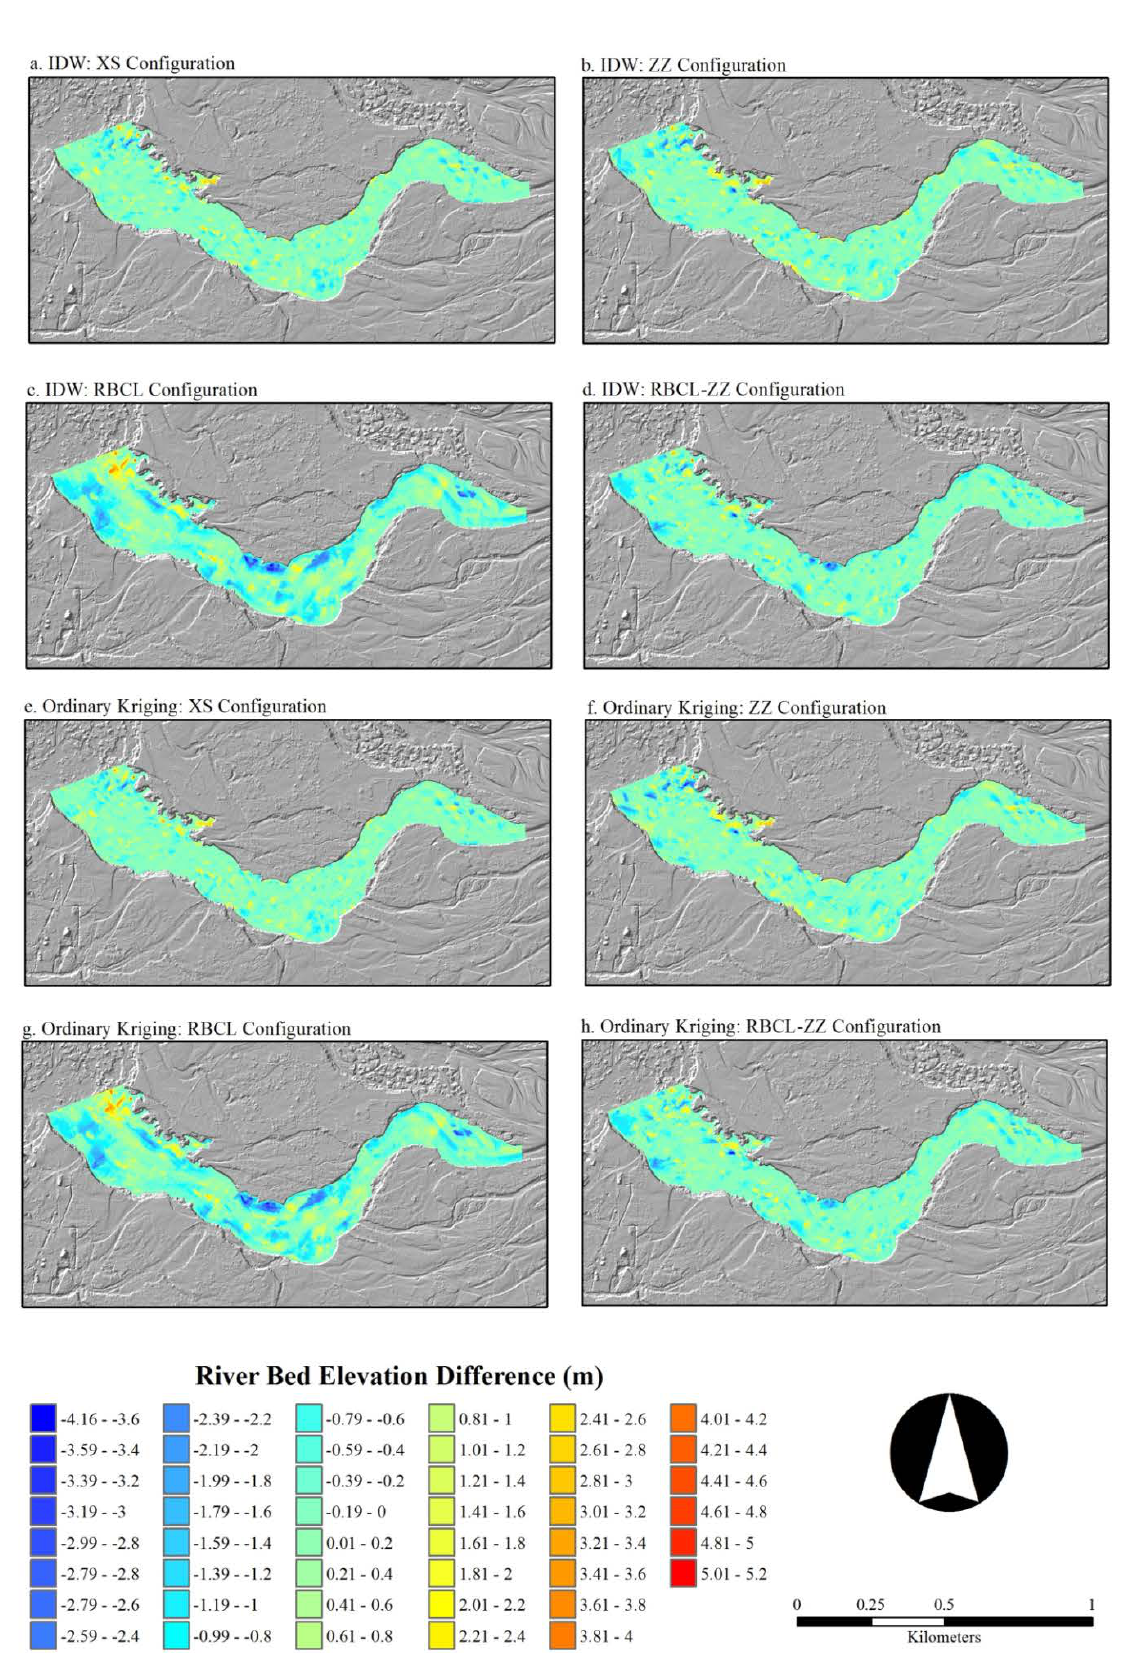
Figure 6.River bed elevation differences between the original DTM and 8 bed-integrated DTMs. A negative difference means the interpolated bed elevation value of that pixel is greater than the true bed